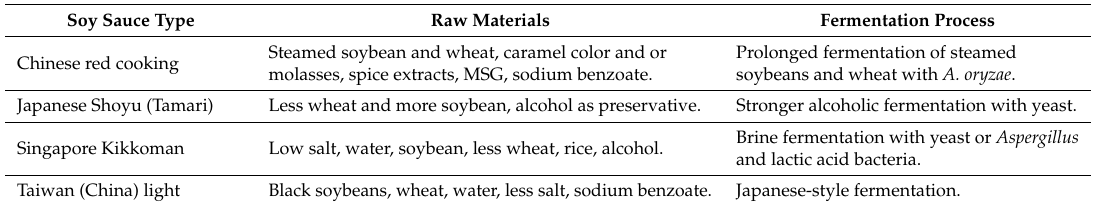
Table 2. Information about the